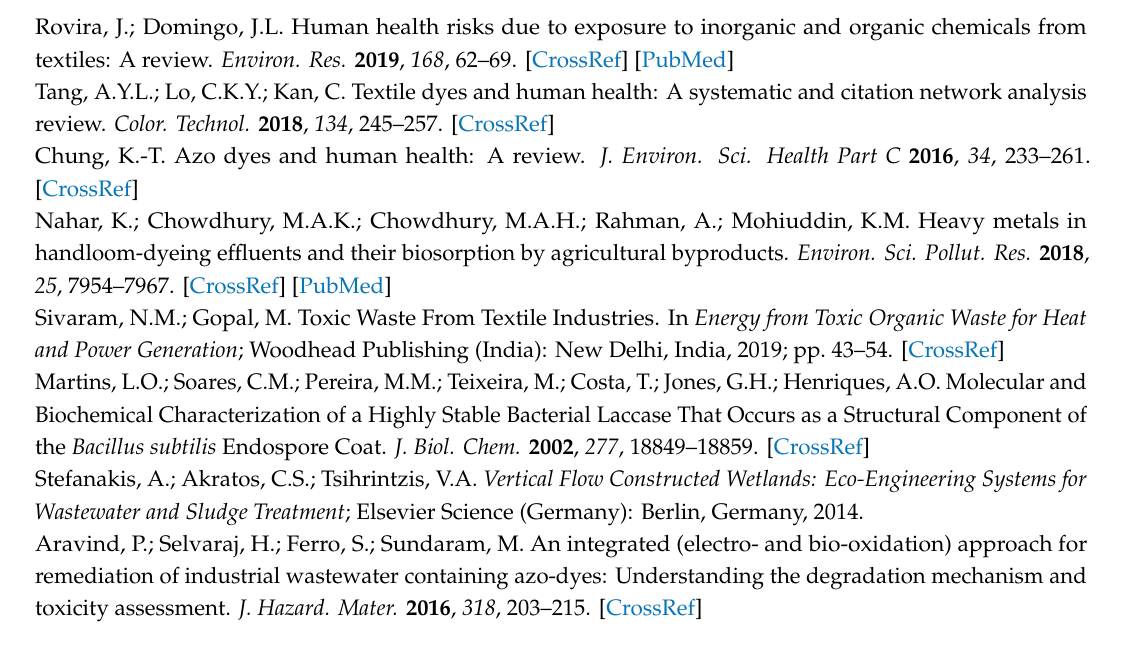
Table S1: Decolorization percentage and residual activity measurements of Free, IL, FreeNW, ILNW, FreeNA and ILNA, Figure S1: Simulation results of combining IL and ILNW filters, Figure S2: Simulation results of combining FreeNW and ILNW filters, Figure S3: Simulation results of combining FreeNW and IL filters, Figure S4: Simulation results of combining ILNW and ILNA filters, Figure S5: Simulation results of combining IL and ILNA filters, Figure S6: Simulation results of combining FreeNW and ILNA filters, Figure S7: Simulation results of combining FreeNA and ILNW filters, Figure S8: Simulation results of combining FreeNA and IL filters, Figure S9: Simulation results of combining FreeNA and FreeNW filters, Figure S10: Simulation results of combining FreeNA and ILNA filters, Figure S11: Simulation results of combining Free and ILNW filters, Figure S12: Simulation results of combining Free and IL filters, Figure S13: Simulation results of combining Free and FreeNW filters, Figure S14: Simulation results of combining Free and ILNA filters, Figure S15: Simulation results of combining Free and FreeNA filters, Figure S16: Simulation results of all two-combinations of the di ff erent types of